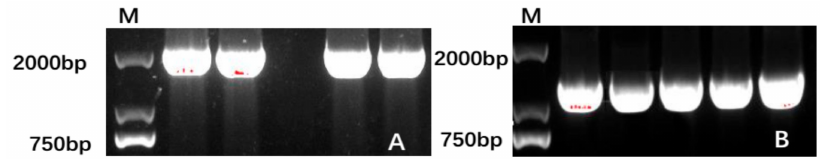
Figure 1. Amplification of the full length Cf4CL and CfCCoAOMT gene cDNA from stem vascular cambium total RNA. Primers used are listed in Table 1. Each lane represents a technical replicate. ( A ) Cf4CL ; ( B ) CfCCoAOMT